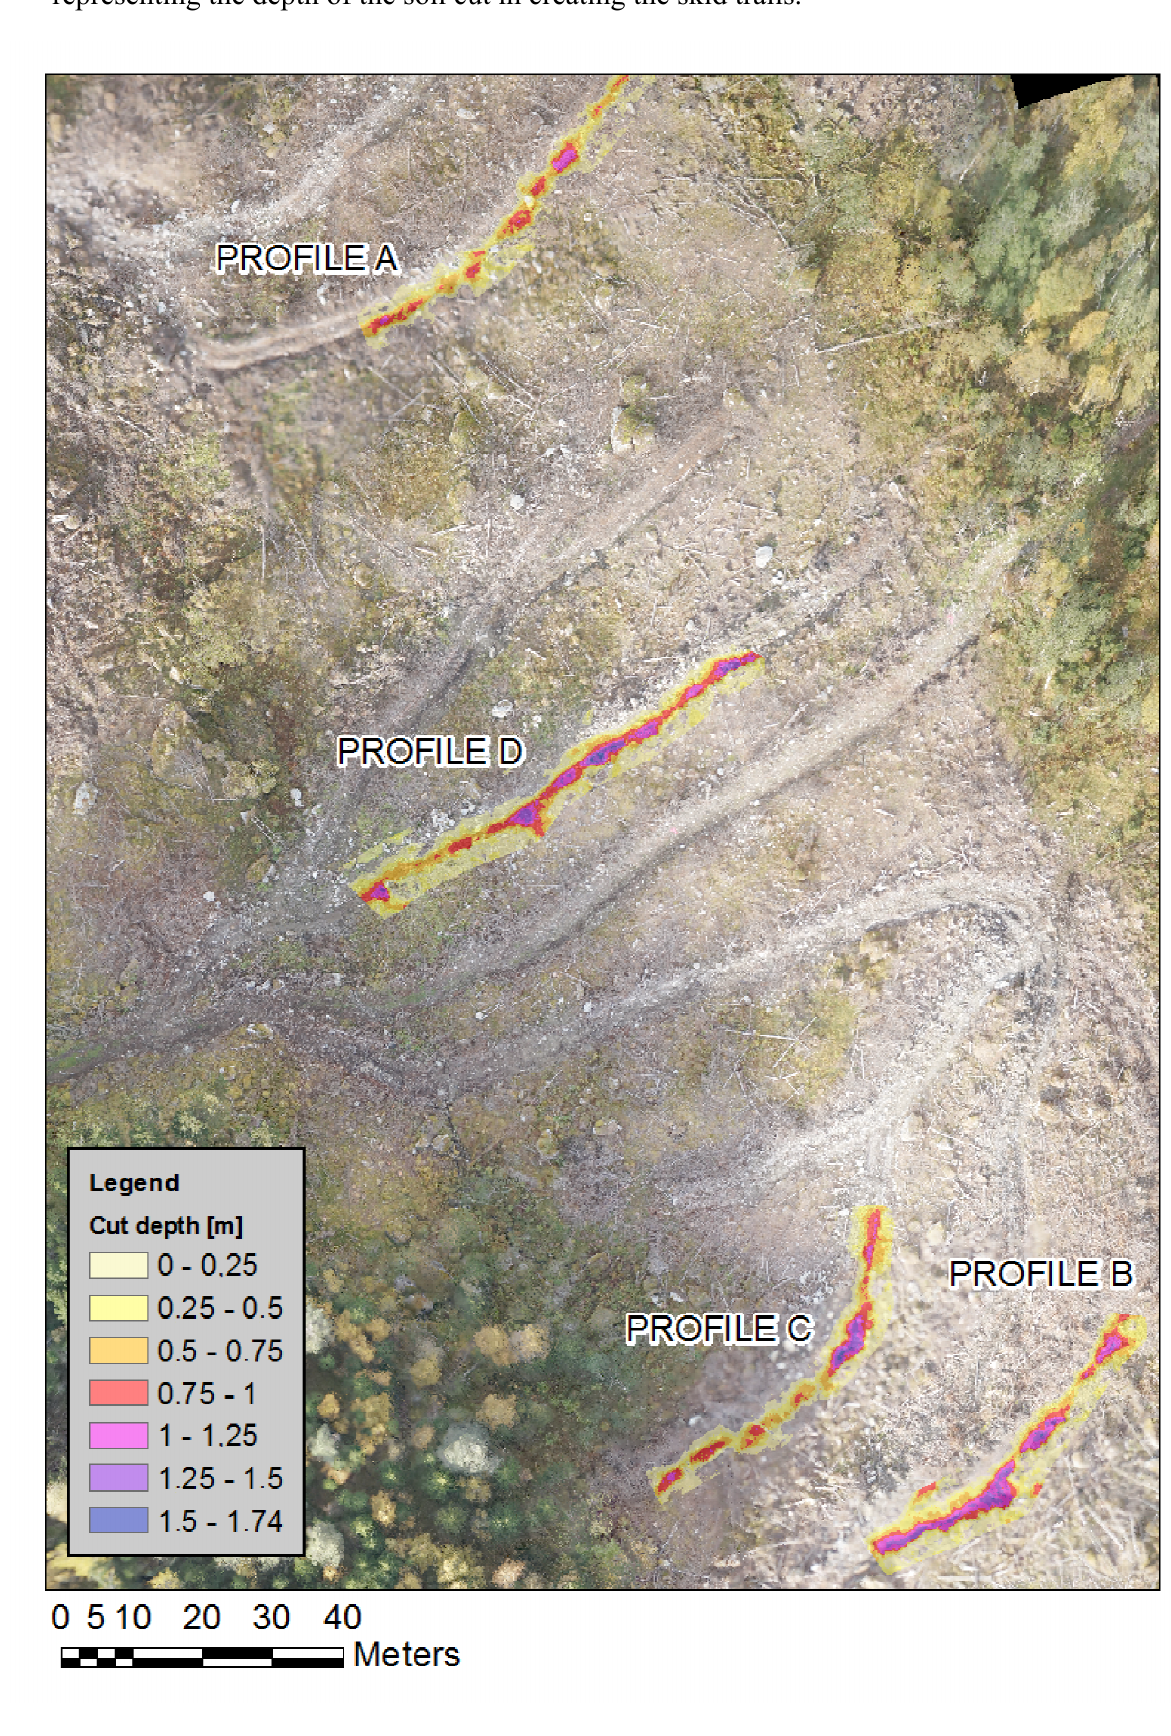
Figure 3. Mosaicked orthophoto of the clearcut area with a semitransparent raster layer representing the depth of the soil cut in creating the skid